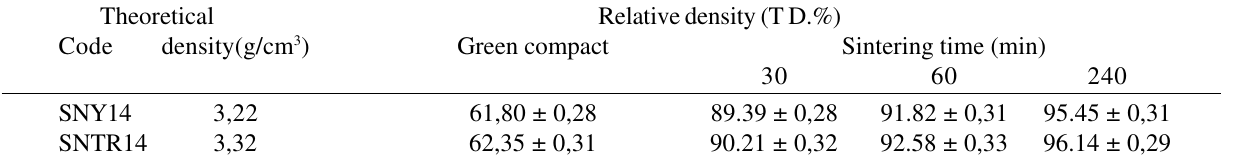
Table 3. Theoretical density (mixture rule), and green and final relative densities after sintering at 1800 °C for 30, 60 and 240 min, of the SNY14 and SNTR14 samples.